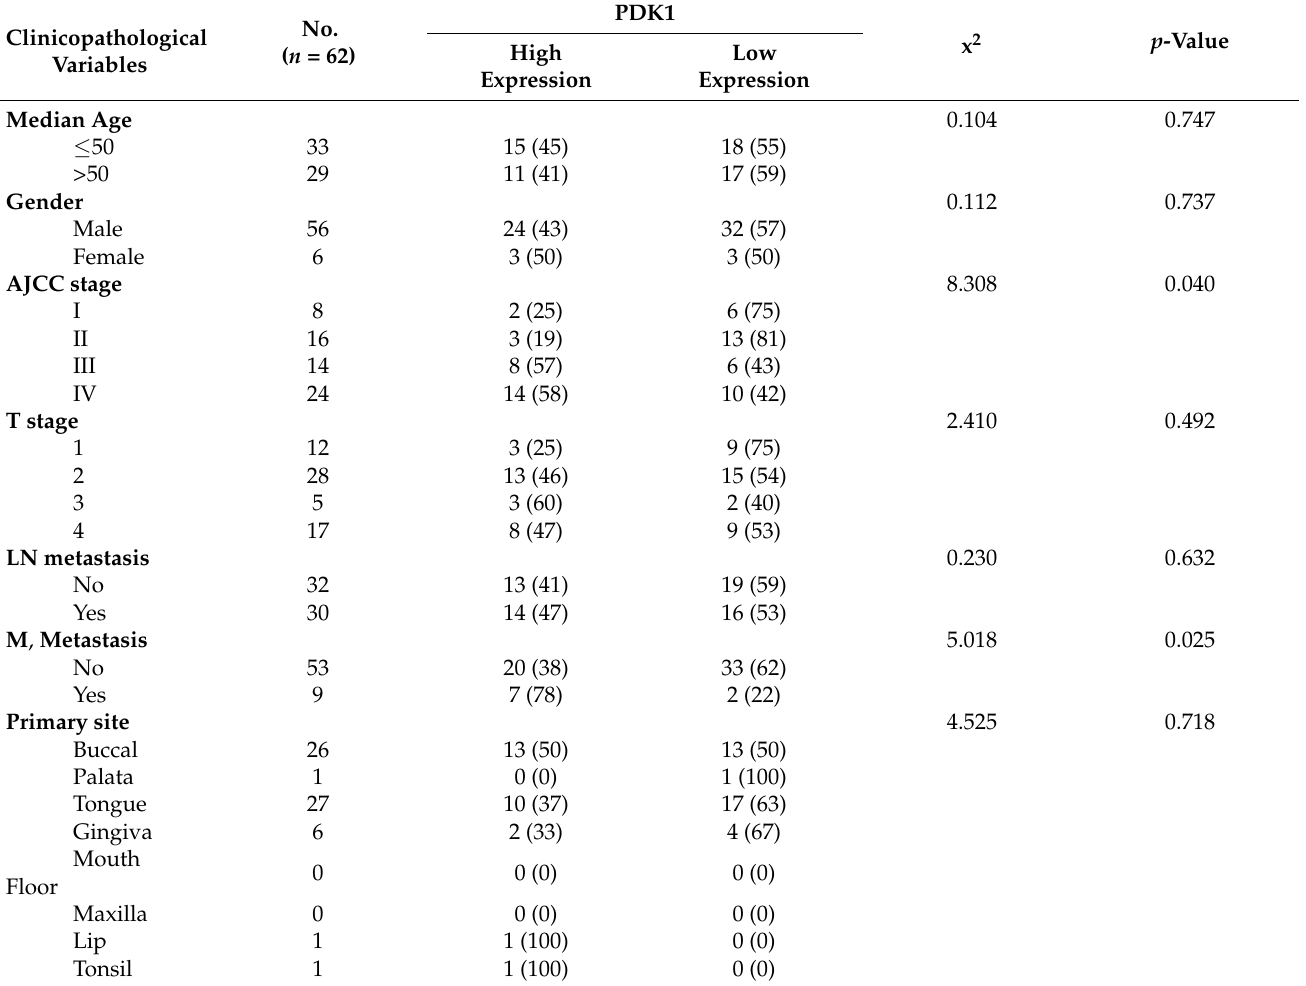
Table 1. TNM classification, PDK1 expression and clinicopathological variables of TSGH OSCC patients. Clinicopathological